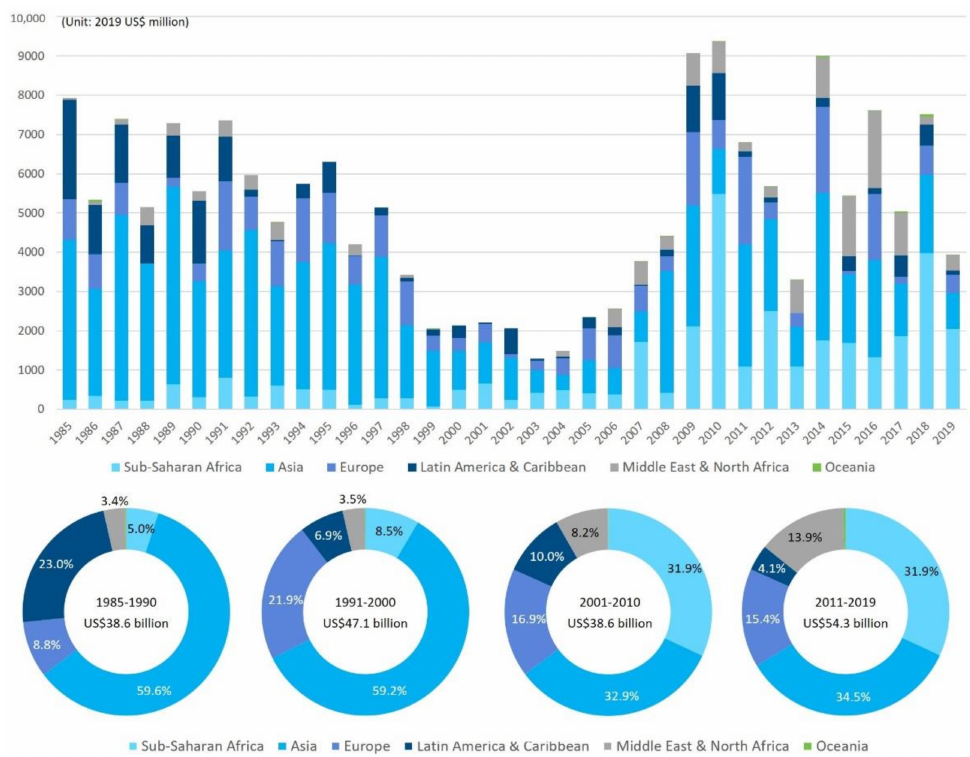
Figure 6. Regional allocation of energy finance (1985–2019). Source: authors’ illustration based on